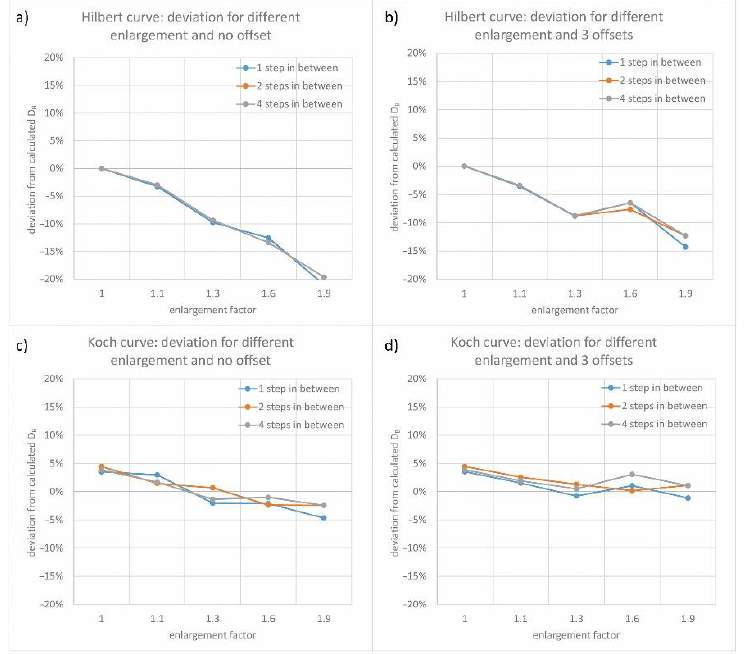
Figure 7. ( a ) Hilbert Curve without offsets; ( b ) Hilbert Curve with 3 offsets; ( c ) Koch Curve without offsets; ( d ) Koch Curve with 3